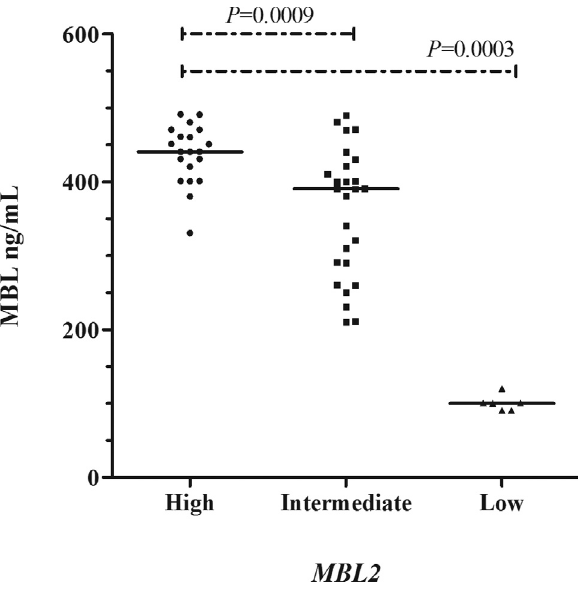
Figure1 -Levelsofserummannose-bindinglectin(MBL)inpatientswith sickle cell anemia according to the genotypes of the promoter and exon-1 of the MBL2 gene. Mann-Whitney test. A: wild-type allele, B, C and D: variant alleles commonly designated as allele O; L and Y: wild-type al- leles; H and X: variant alleles. The following combined MBL2 genotypes were considered to yield high MBL concentrations: HYA/HYA, HYA/LYAandLYA/LYA(median=440.4,range=330.5-490.9,n=20), intermediate concentrations: HYA/HYO, HYA/LXA, HYA/LYO, LYA/LXA, LXA/LXA, LYA/LYO and HYO/LYA (median = 390.4, range = 210.3-490.0, n = 26) and low concentrations: HYO/LXA, LXA/LYO and LYO/LYO (median = 100.3; range = 90.6-120.3, n =